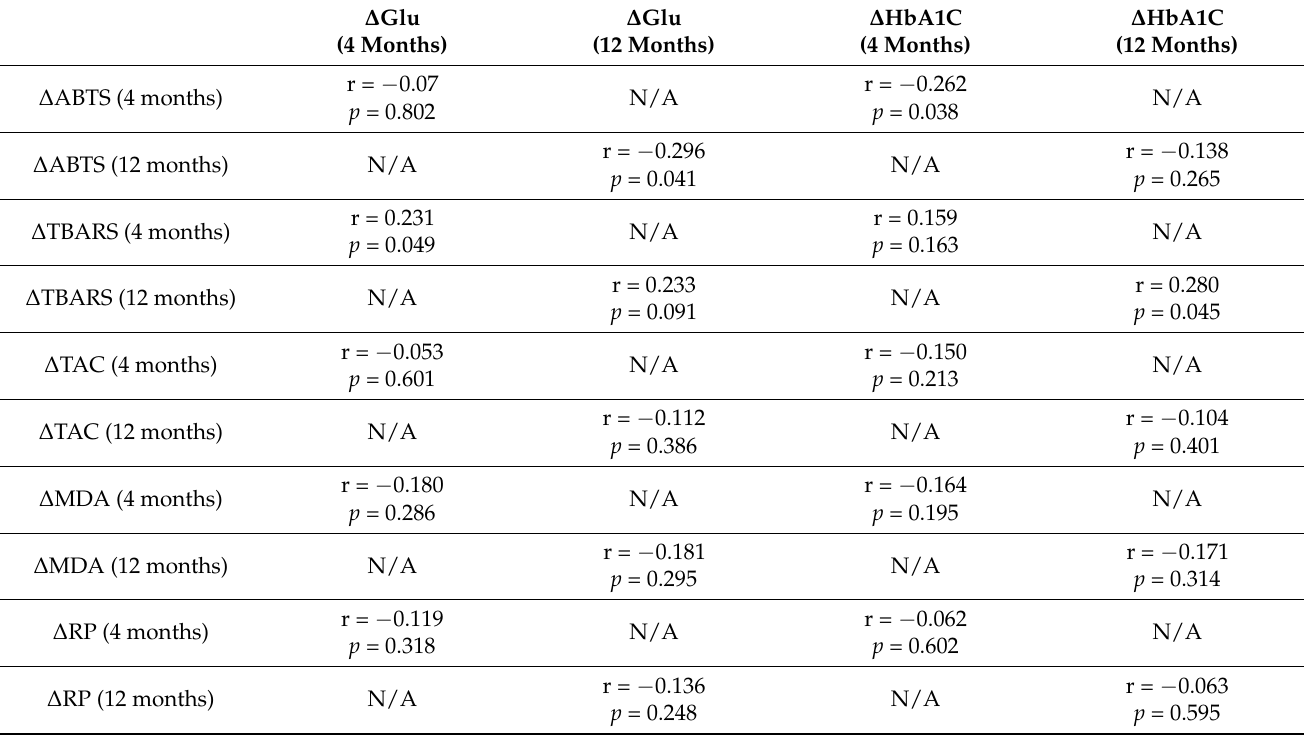
Table 3. Correlations of glycemic control with changes of oxidative stress markers. Data are presented as percentages. ∆ ABTS: the percentage change of 2,2¢-azino-bis-(3-ethylbenzthiazoline-6-sulphonic acid) radical; ∆ Glu: the percentage change of fasting plasma glucose; ∆ HbA1C: the percentage change of glycated hemoglobin; ∆ MDA: the percentage change of Malondialdehyde; ∆ RP: the percentage change of Reducing Power; ∆ TAC: the percentage change of Total Antioxidant Capacity; ∆ TBARS: the percentage change of Thiobarbituric Acid Reactive Substances; N/A: Not